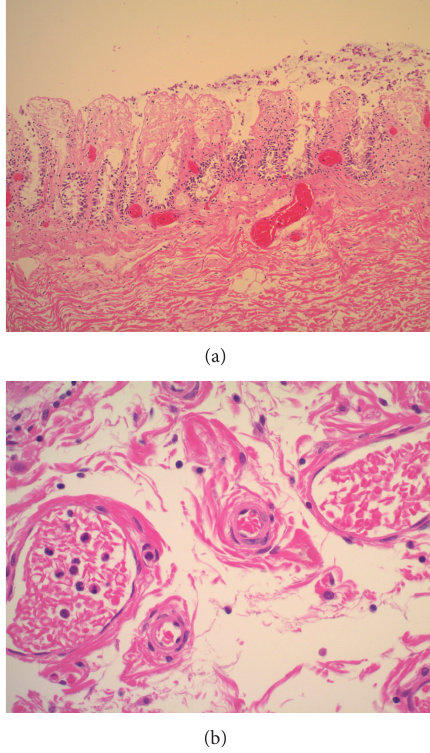
Figure 2: (a) shows colon with congestion of capillary venules and ischemic necrosis of overlying mucosa. (b) shows sickle-shaped red blood cells in congested capillary